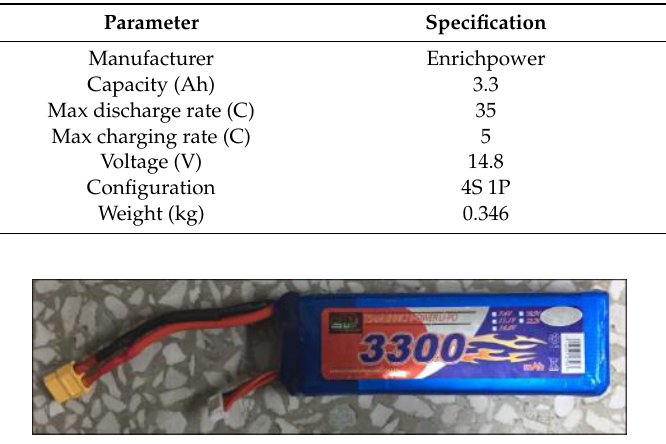
Figure 6. Overview of the LiPo battery pack.